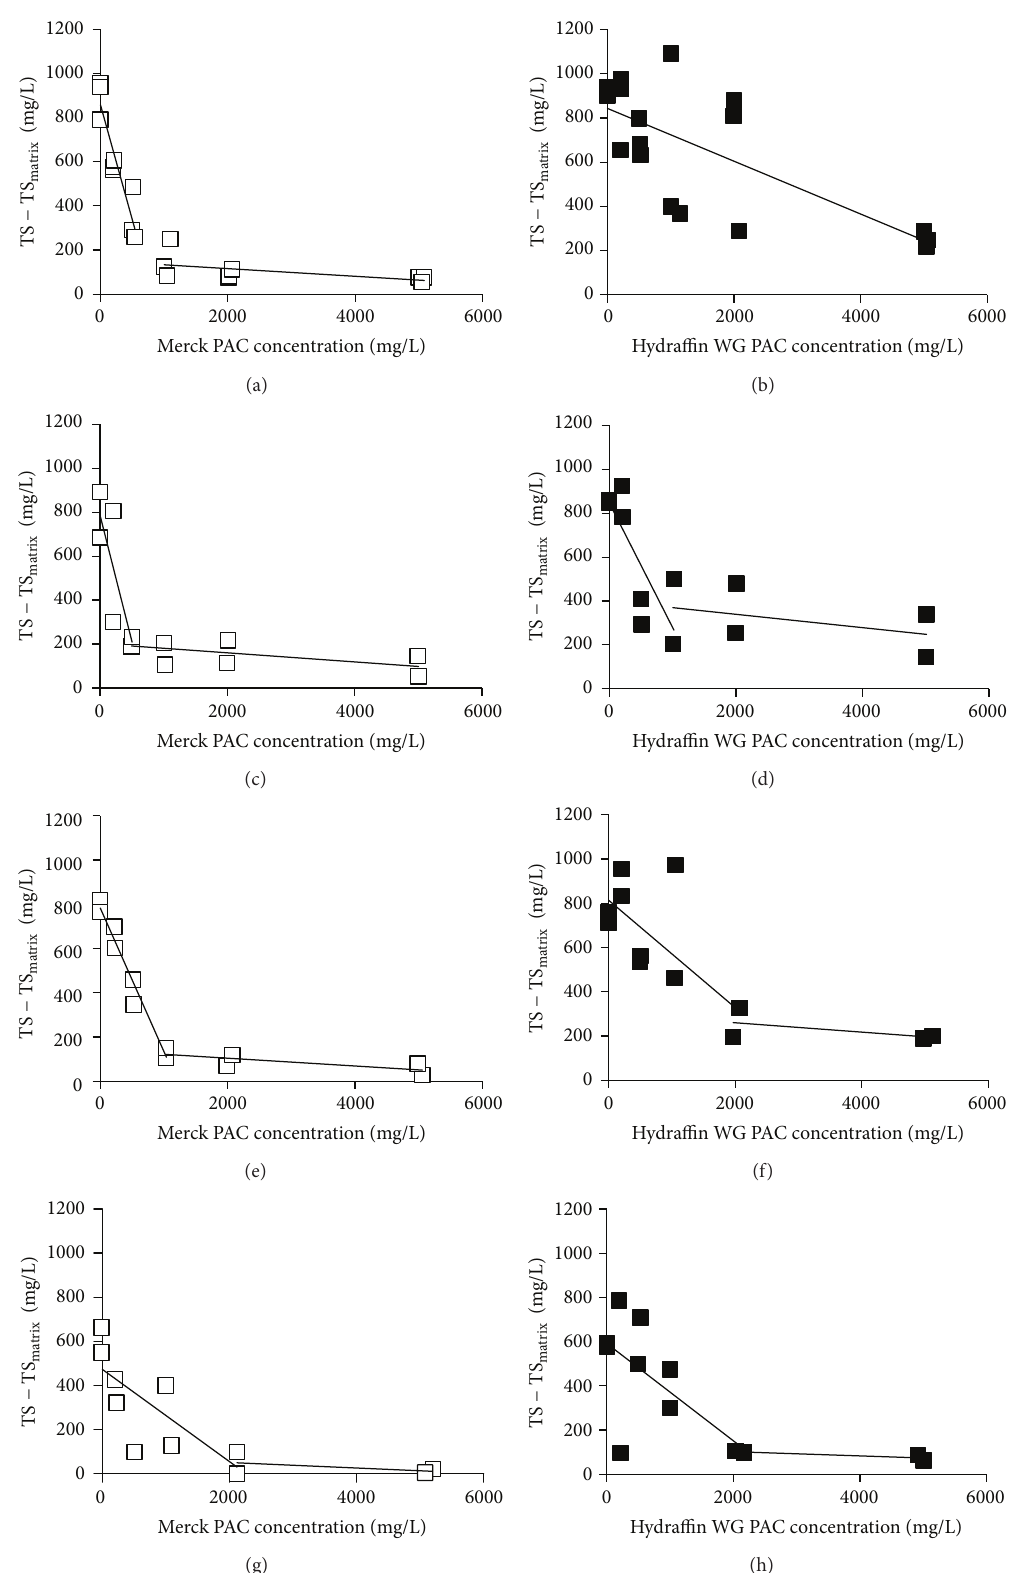
Figure4:Totalsolidsconcentrations(correctedforTSconcentrationsofthematrices)in1g/LTiO 2 suspensionscontainingdifferentamounts of Merck PAC or Hydraffin WG PAC in different matrices ((a), (b): deionized water; (c), (d): 0.1g/L NaCl solution; (e), (f): 0.5 g/L NaCl solution; (g), (h): 1g/L NaCl solution) subsequent to vacuum filtration over spunbond polypropylene